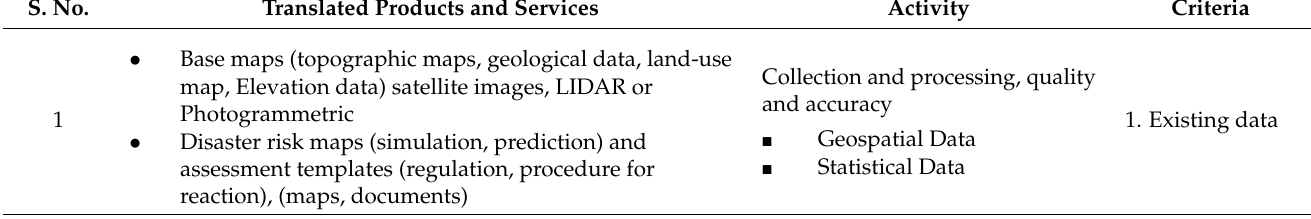
Table 1. Spatial data criteria based on the priorities of the two frameworks. S.